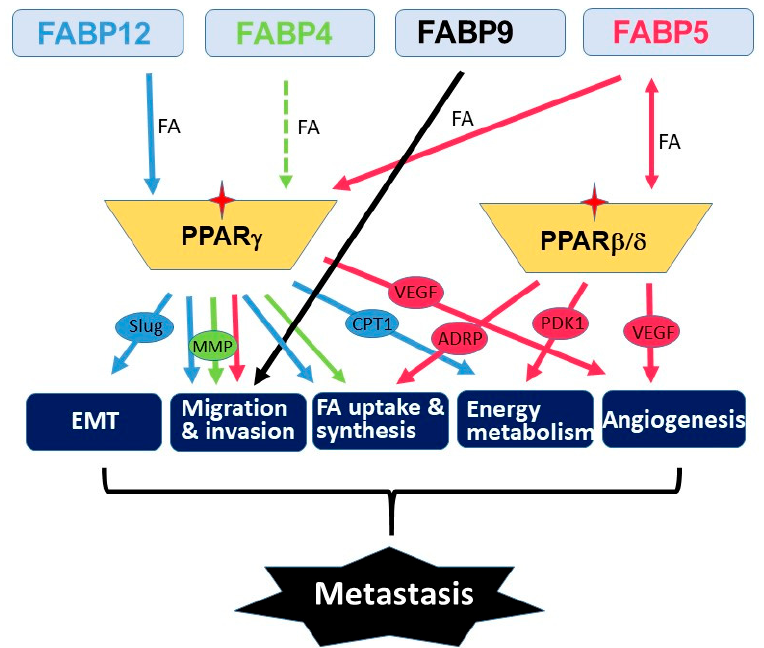
Figure 4. Schematic illustration of the molecular pathways underlying the roles of FABPs co-amplified in PCa. We propose that each FABP contributes to critical processes (e.g., epithelial-to-mesenchymal transition (EMT), cell migration / invasion, FA uptake / synthesis, energy metabolism and angiogenesis) that leads to metastatic progression. The fatty acid-activated nuclear receptors (PPAR β / δ and PPAR γ ) serve as key mediators in FABPs’ pro-metastatic functions in PCa. Downstream e ff ectors of PPARs are shown in ovals. Stars denote activation of PPARs. Broken lines indicate unproved functions.